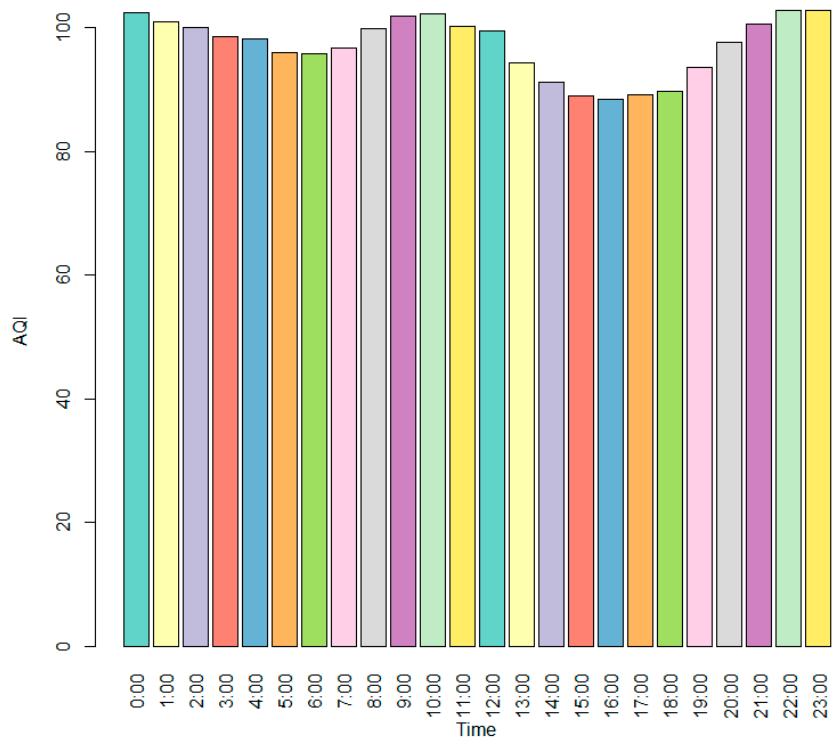
Figure 4. The distribution of the AQI at different hours.